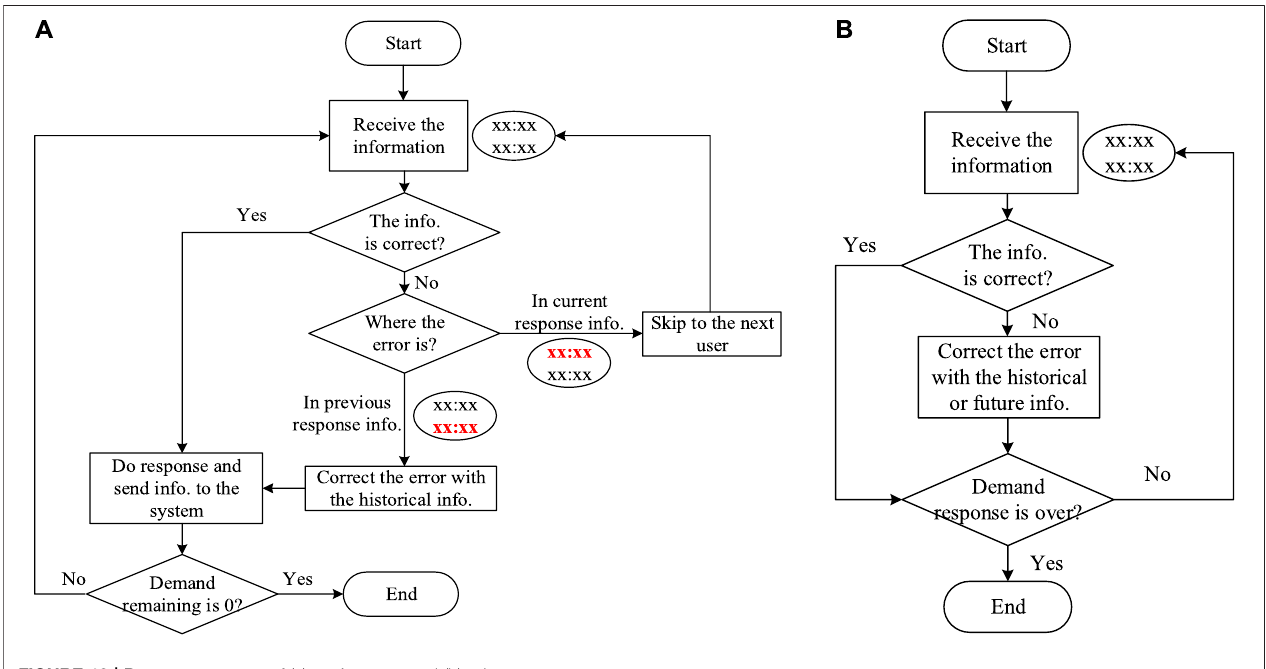
FIGURE 10 | Response strategy of (a) an Accepter and (b) a Learner.